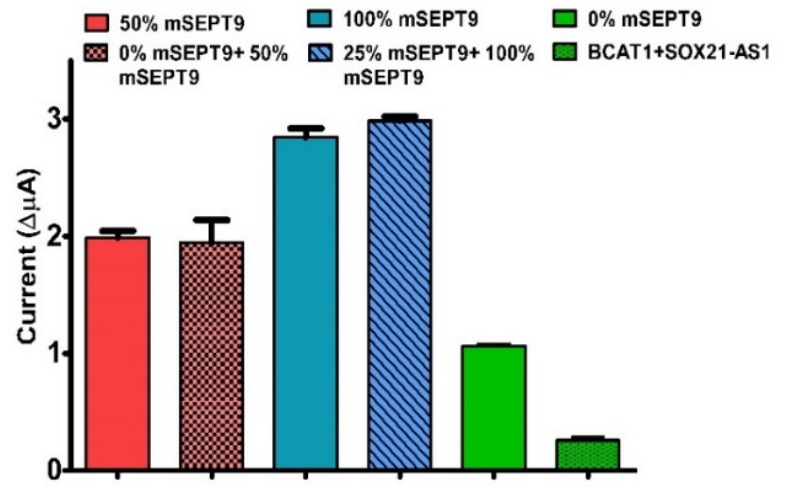
Figure 5. The response of the sensor towards different interferants including BCAT1 and SOX21-AS and various SEPT9 methylation levels.